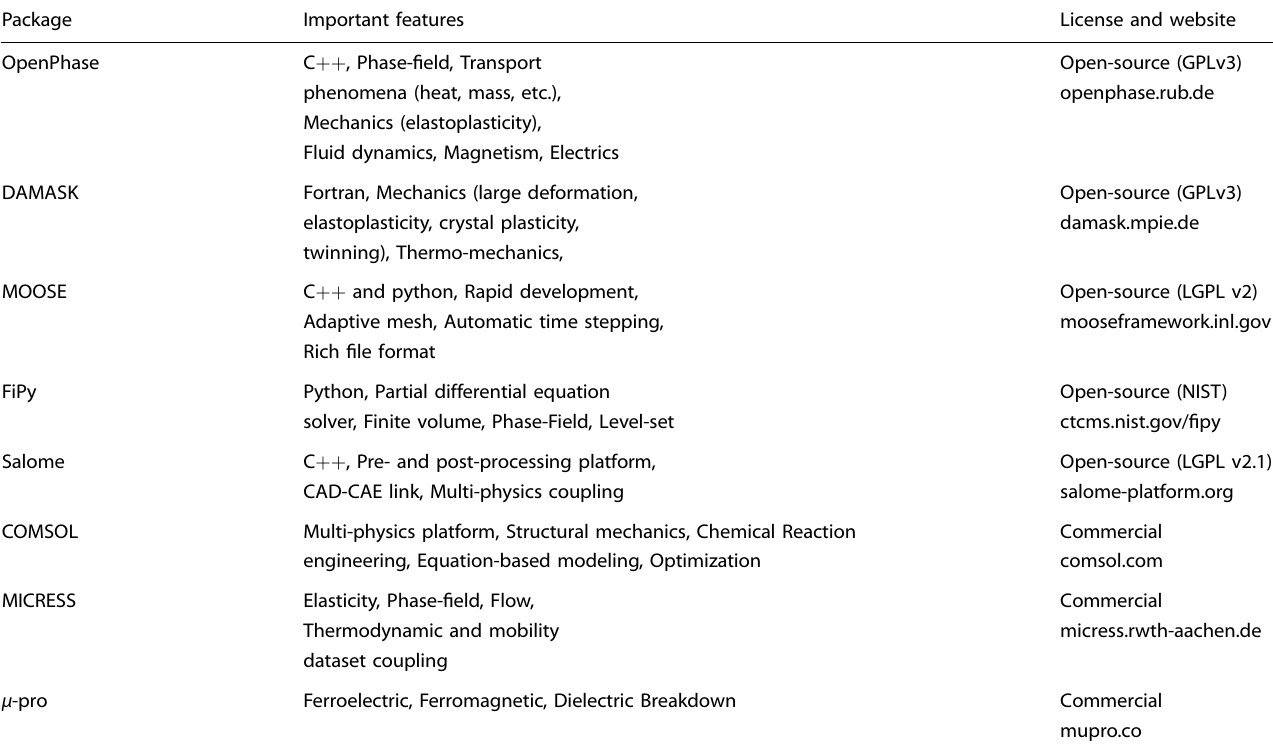
Table 1. Software packages and important features for multi-physics modeling in metallic systems.